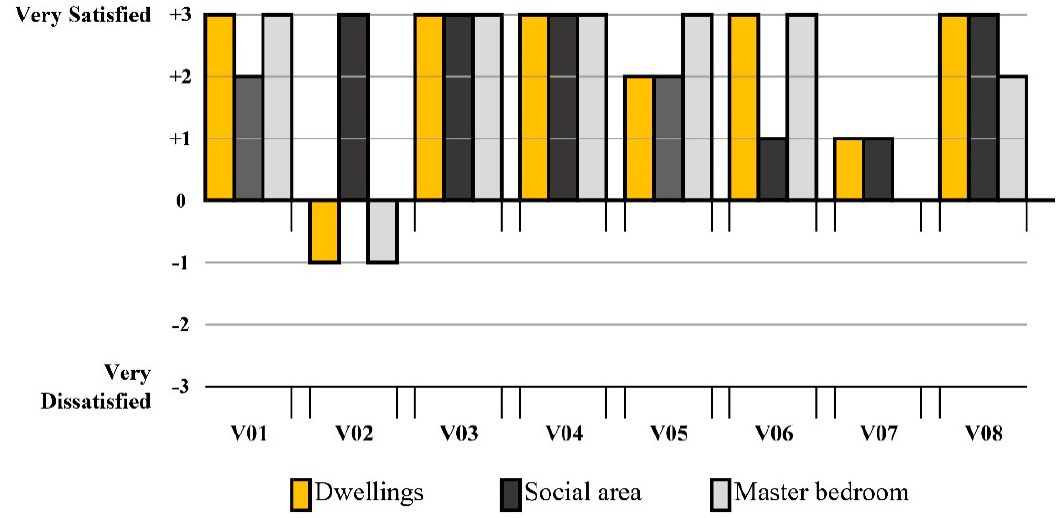
Figure 12. Natural illumination levels (lux) of the studied houses.